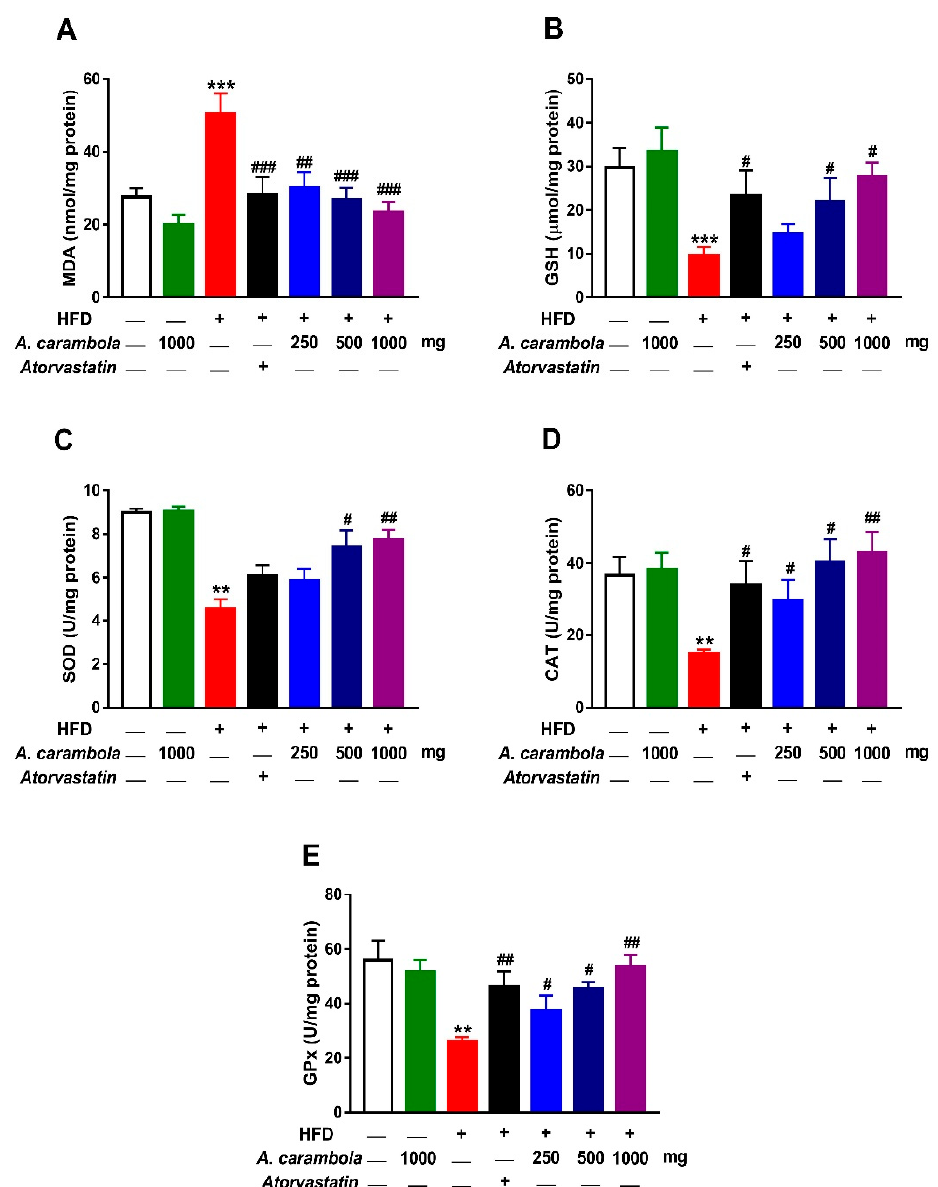
Figure 7. Effect of MEACL on selected in vivo antioxidant parameters in the liver of HFD-induced chronic hyperlipidemic rats. MEACL reduced hepatic MDA ( A ), and increased GSH ( B ), SOD ( C ), CAT ( D ) and GPx ( E ) in HFD-fed rats. MDA, malondialdehyde; SOD, superoxide dismutase; GSH, reduced glutathione; GPx, glutathione peroxidase. Values are expressed as mean ± SEM, n = 3. ** p < 0.01, *** p < 0.001 compared to normal control. # p < 0.05, ## p < 0.01, ### p < 0.001 compared to hyperlipidemic control.